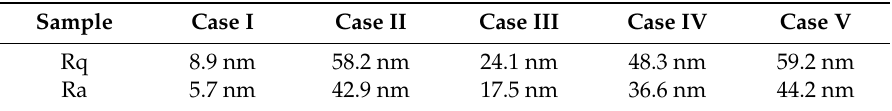
Table 3. Root mean square roughness (Rq) and average roughness (Ra) obtained from AFM images of TAC film surfaces of Figure